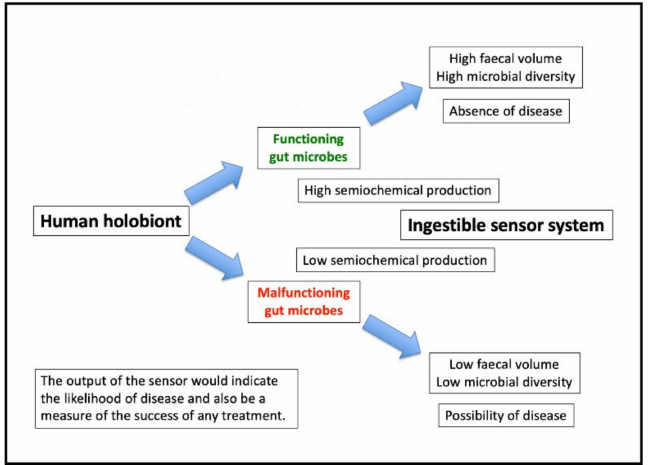
Figure 1. Illustrates the consequences of altered microbiome function and variable semiochemical